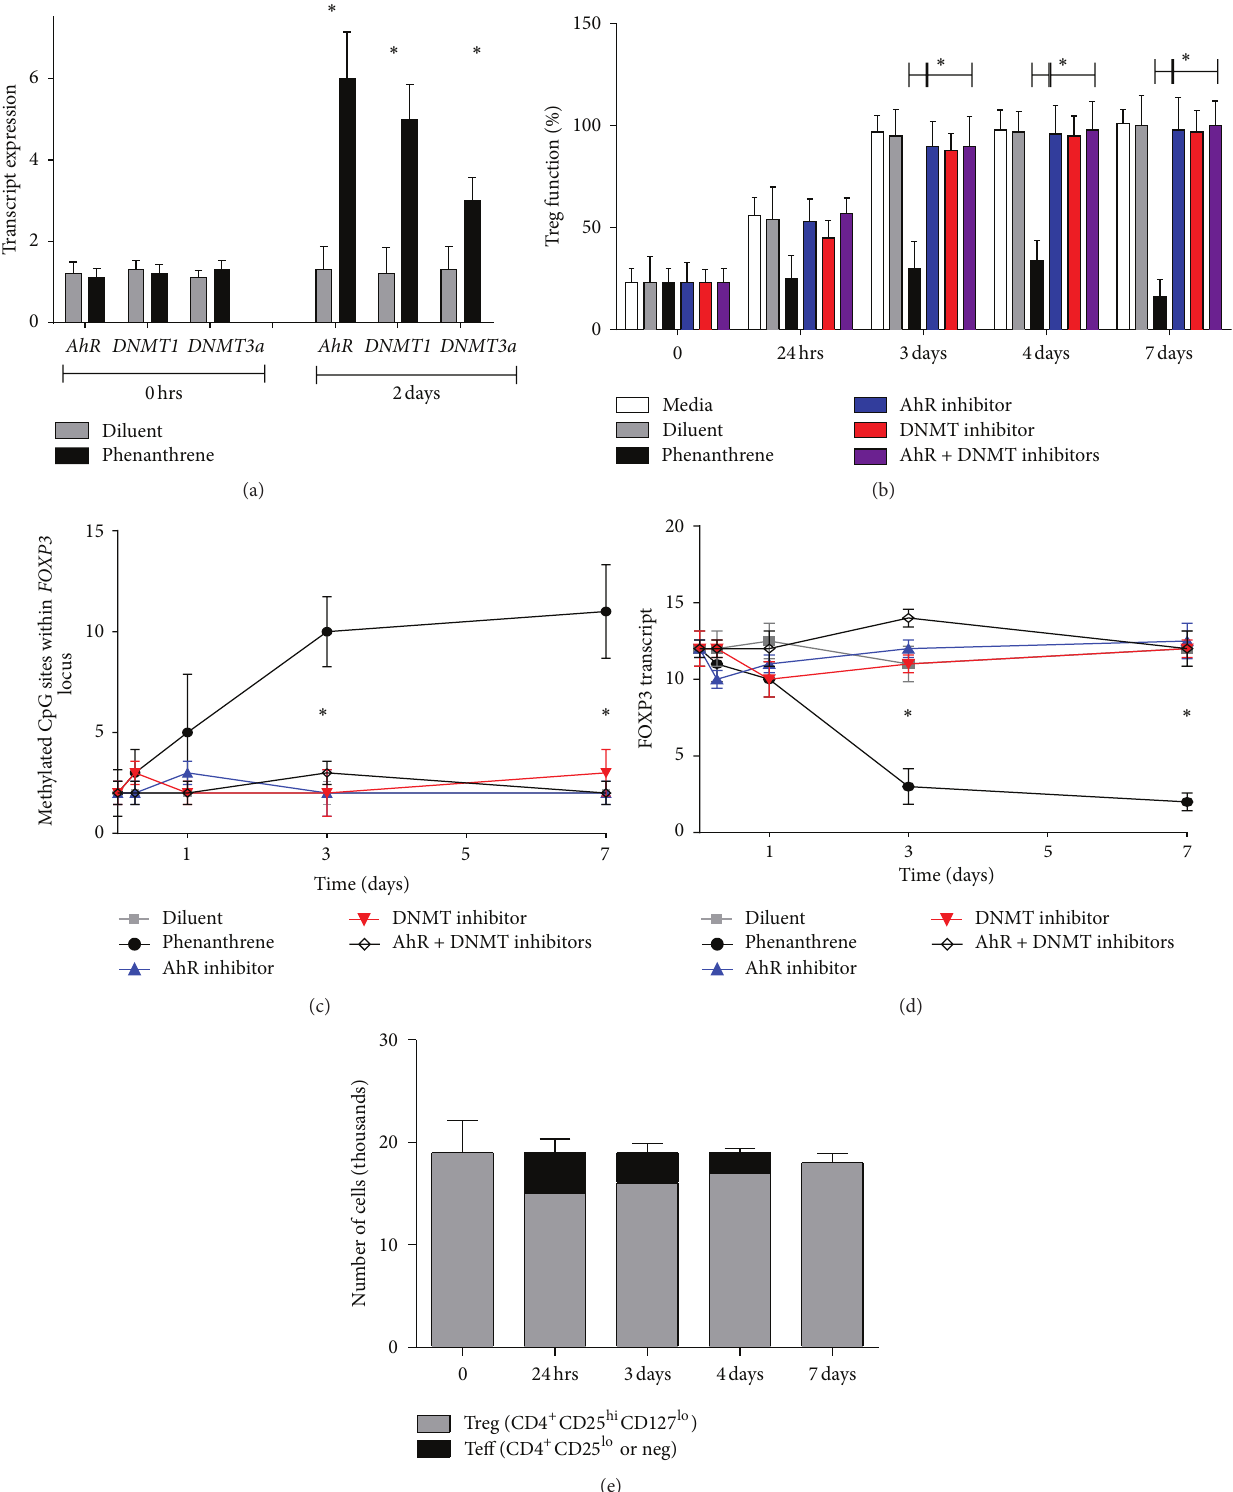
Figure 6: AhR, DNMT1, and DNMT3b mediate Phe’s effects on Treg. (a) Treg purified from healthy donors ( 𝑛 = 5 ) were treated with 300 nM Phe (black bars) or diluent (grey bars) for 2 days followed by quantification of AhR , DNMT1, and DNMT3b transcript by QT-PCR. Treg function, (b) FOXP3 locus methylation (c), and FOXP3 transcript (d) were assessed in 7-day Treg cultures treated with diluent (grey) and Phe (black) or co-incubation with Phe and the DNMT inhibitor decitabine (1uM; red), AhR inhibitor 3 󸀠 ,4 󸀠 -dimethoxy-flavone (10uM; blue) or both inhibitors (purple). (e) Conversion of Treg to Teff in 7-day cultures treated with Phe + 3 󸀠